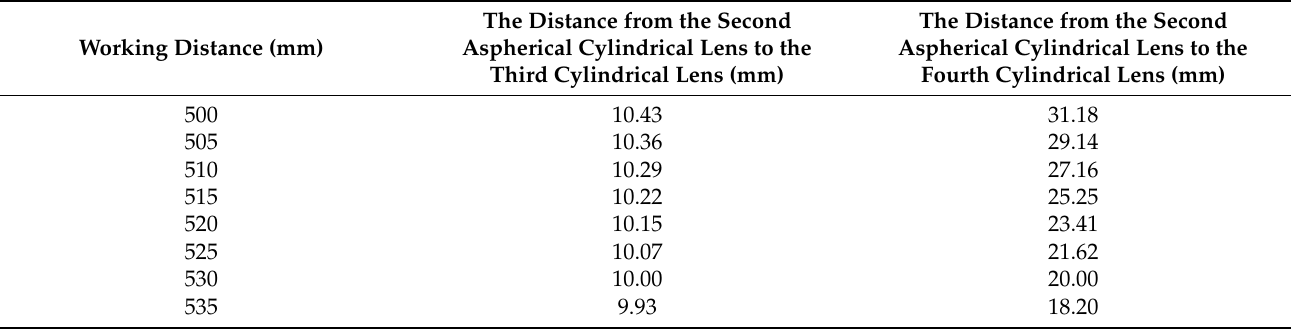
Table 5. Working distance and displacement parameters of the zoom lens system.